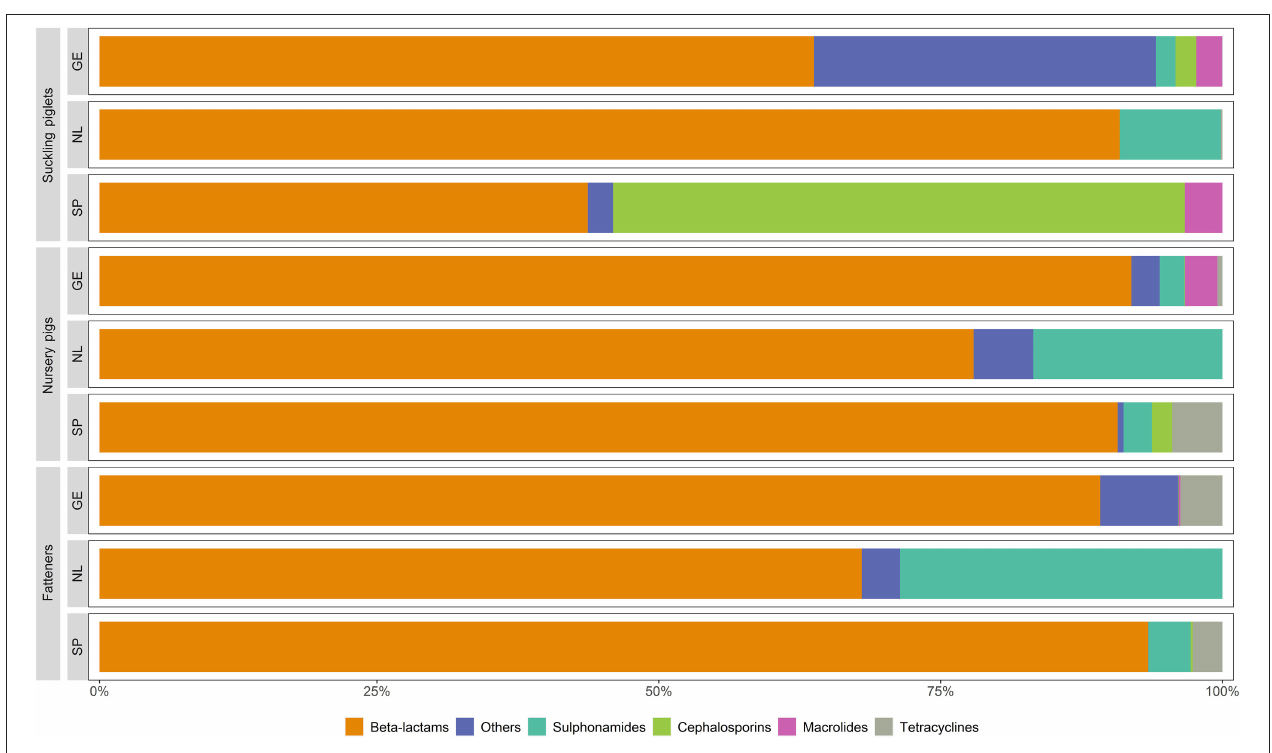
FIGURE 3 | Proportions of the costs of antimicrobials per animal in affected production units by antimicrobial families for the countries of study.